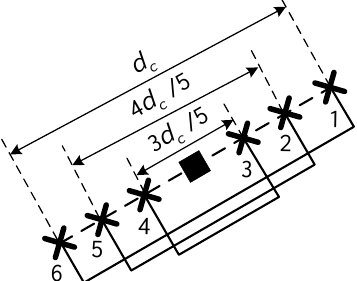
Figure 6. Two different configurations of C-MRCJ with six antenna elements. The platform is denoted by a black square. ( a ) Configuration 1 where α 1 = α 3 = 15 ◦ , α 2 = 150 ◦ . ( b ) Configuration 2 where α 1 = α 2 = α 3 = 60 ◦ .